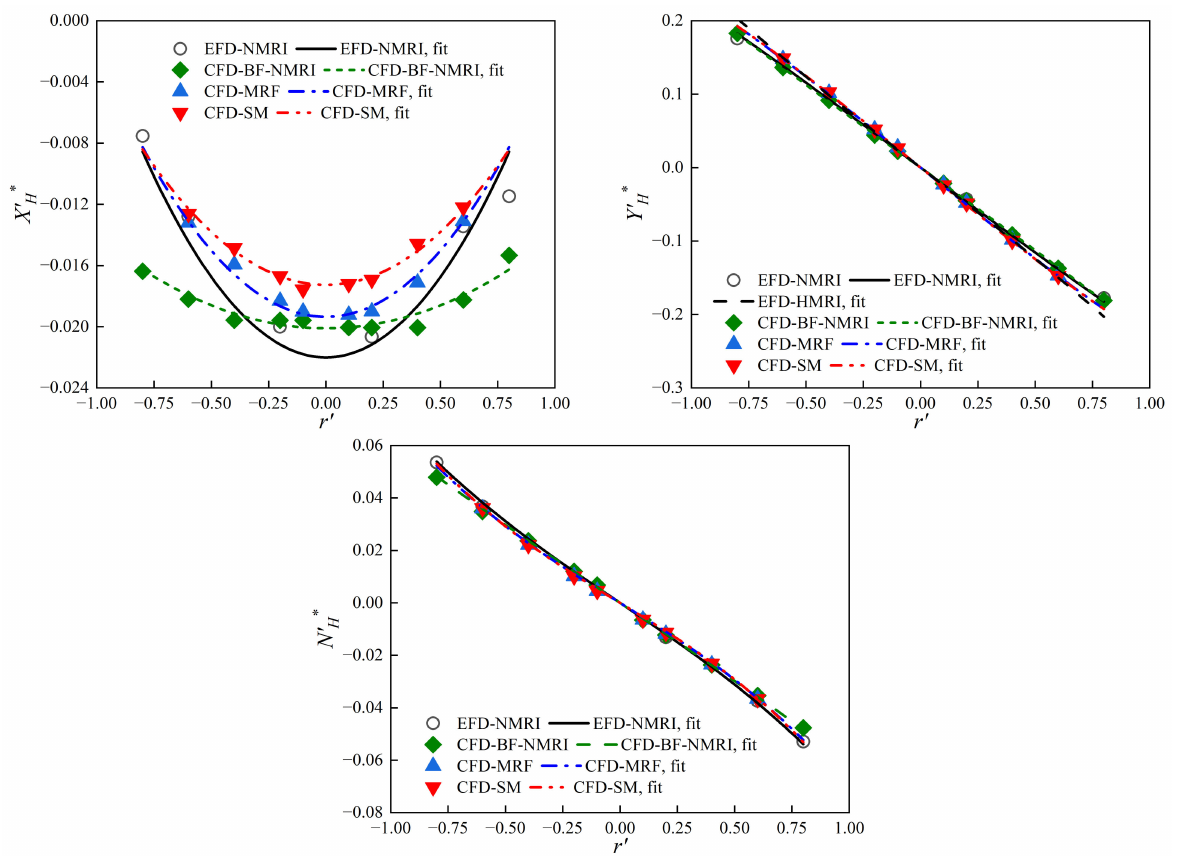
Figure 11. Hydrodynamic forces on the hull obtained from CMTs ( β = 0 ◦ ) and corresponding fitting